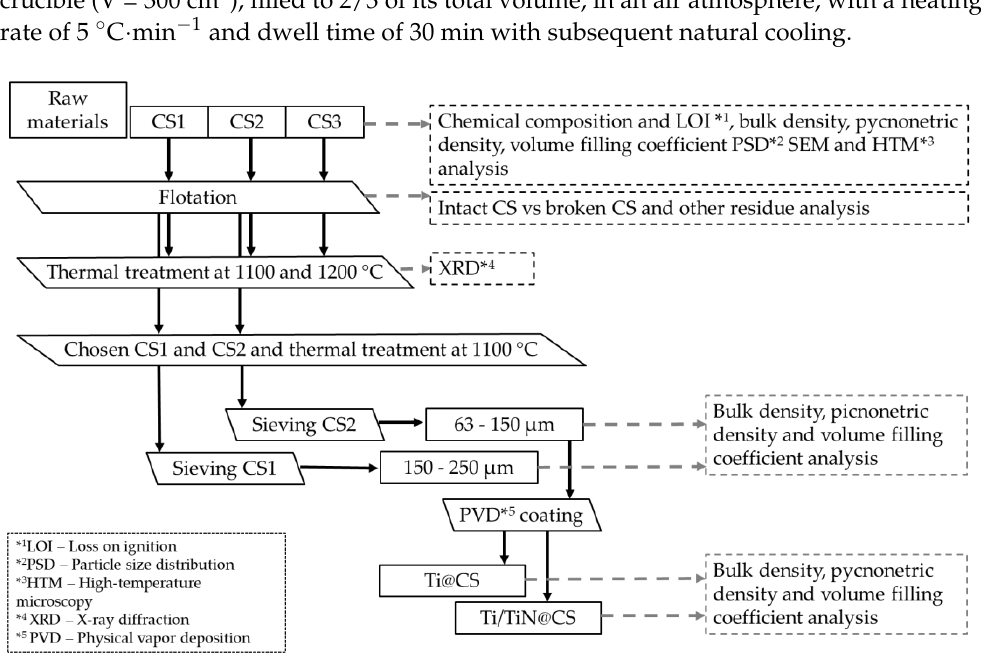
Figure 1. Flowchart depicting the process flow and characterization after each